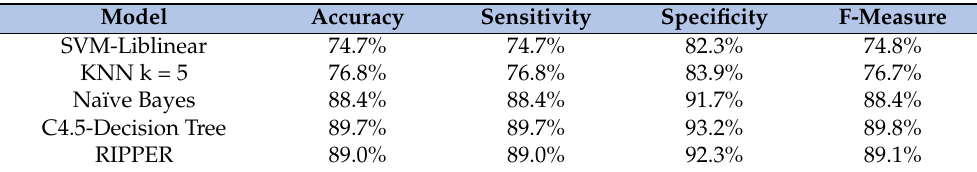
Table 2. Experiment